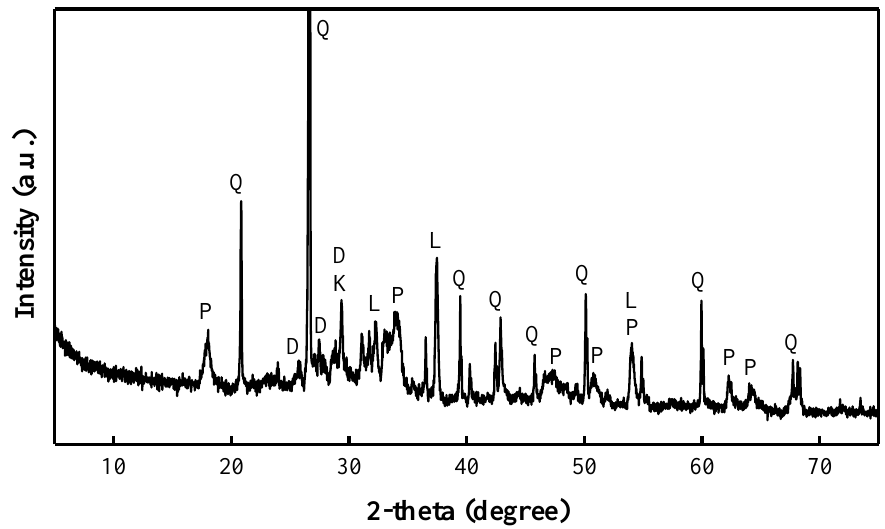
Figure 5. XRD pattern of the BFA (Q: quartz; D: dicalcium silicate; P: portlandite; L: lime; K: calcite).